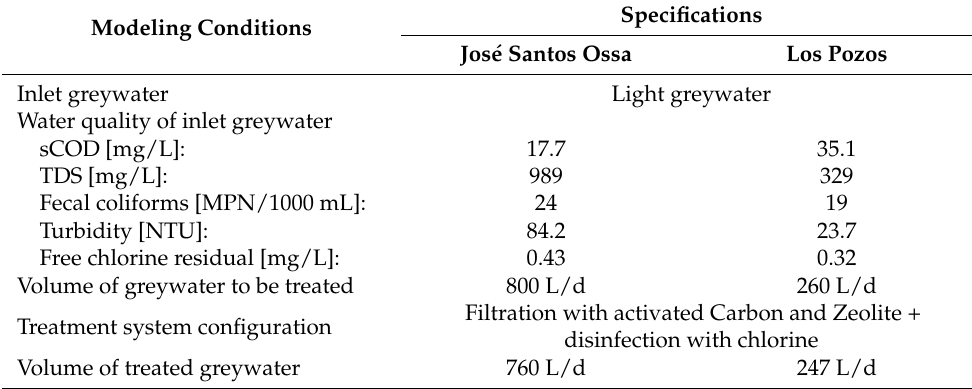
Table 1. Modeling conditions of scenario 1 (Light greywater